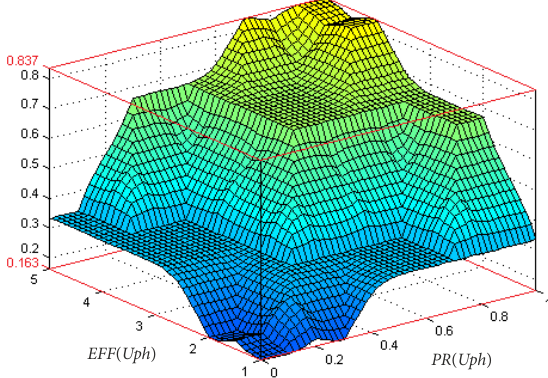
Figure 7. Surface solutions – centre of gravity